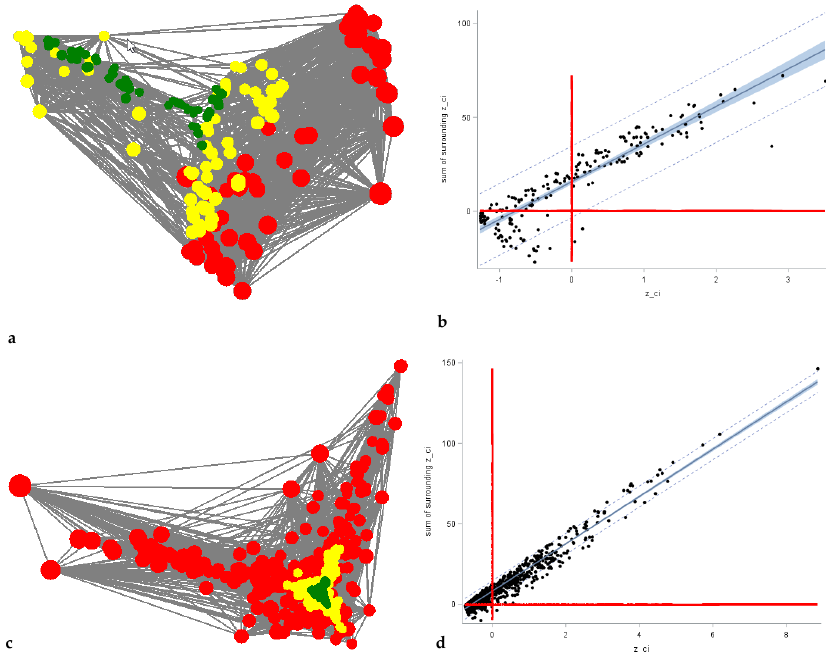
Figure 5. Selected publicly available social network series dataset visualizations. A topological centrality index portrayed by choropleth proportional circles; green denotes relatively small values, yellow denotes intermediate values, and red denotes relatively large values. Top left ( a ): a jazz musician social network. Top right ( b ): A Moran scatterplot for Figure 5a, with 95% confidence (solid blue) and prediction (dotted blue lines) intervals. Bottom left ( c ): an e-mail social network. Bottom right ( d ): A Moran scatterplot for Figure 5c, with 95% confidence (solid blue) and prediction (dotted blue lines) intervals.